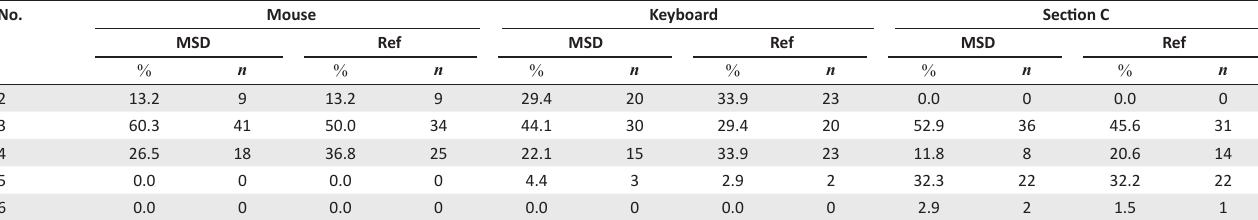
TABLE 7: Sub-scores of the rapid office strain assessment (Section C). No. Keyboard Section C